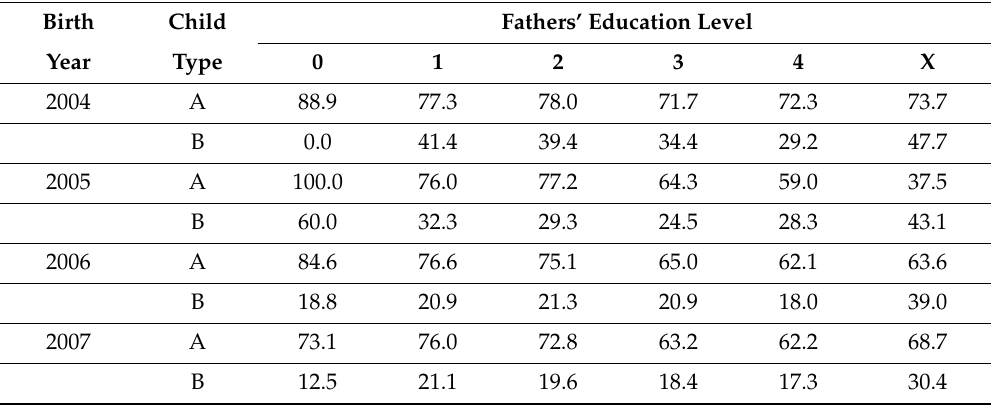
Table 4. Return rates by fathers’ education level per birth cohort in 2016. Birth